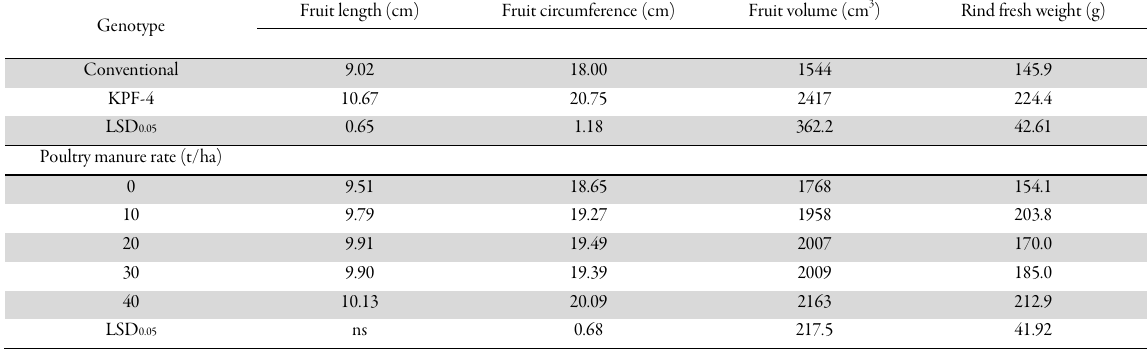
Table 2. Main effects of genotype and poultry manure rates on fruit metric traits of yellow passion fruit grown in the field in 2015 Genotype